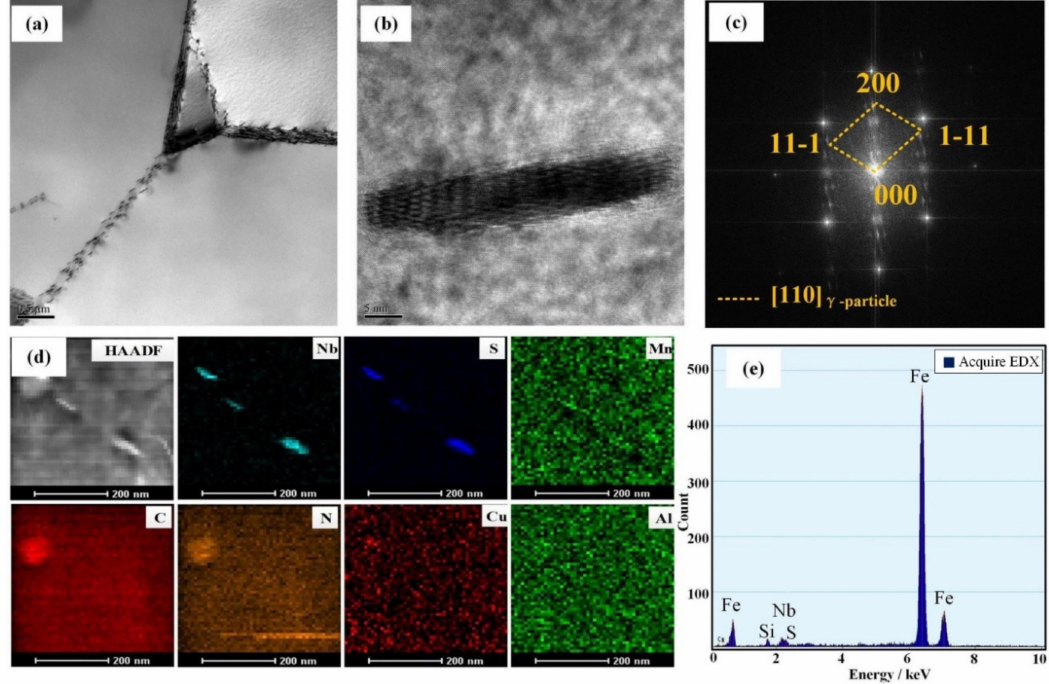
Figure 5. TEM micrograph ( a ), HR-TEM micrograph ( b ), FFT di ff ractogram ( c ), EDX-STEM maps ( d ) and EDX spectrum ( e ) of precipitates in as-cast